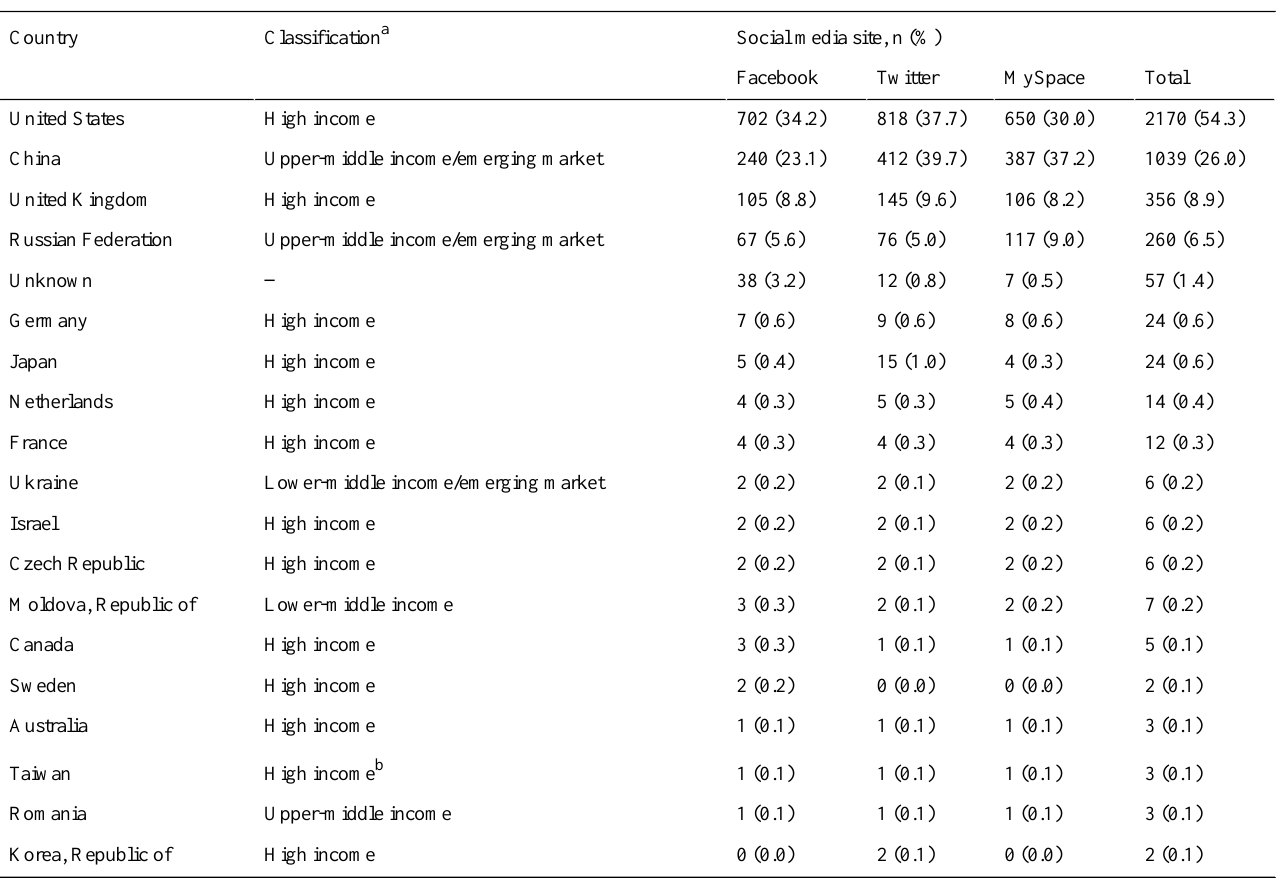
Table 3. Illicit eDTCA user location data.